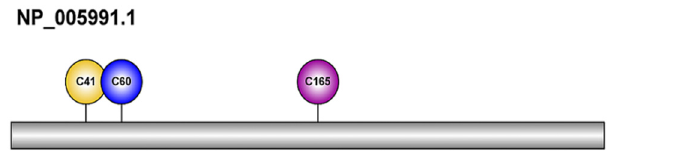
Fig 5. The predictive IBS results of the online